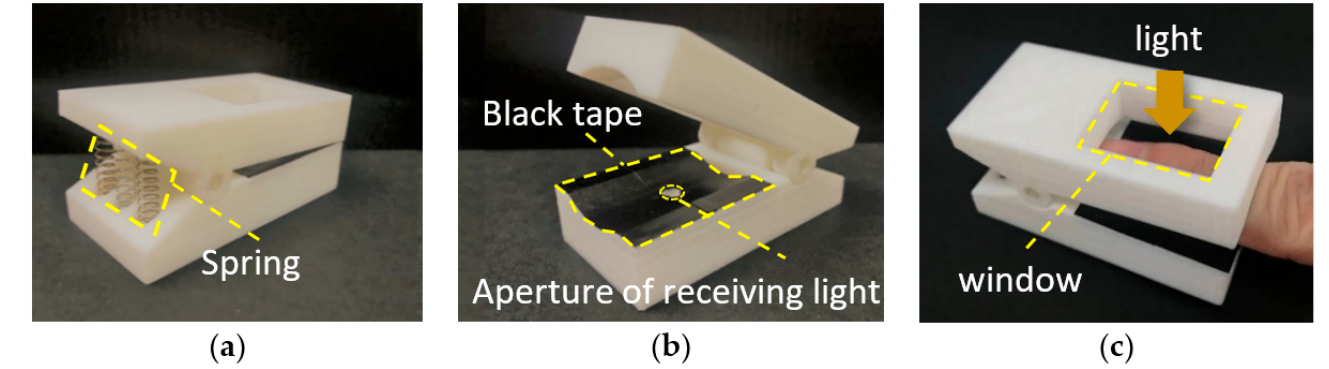
Figure 2. Design of 3D printed finger clip device ( a ) back side ( b ) front side ( c ) top side.